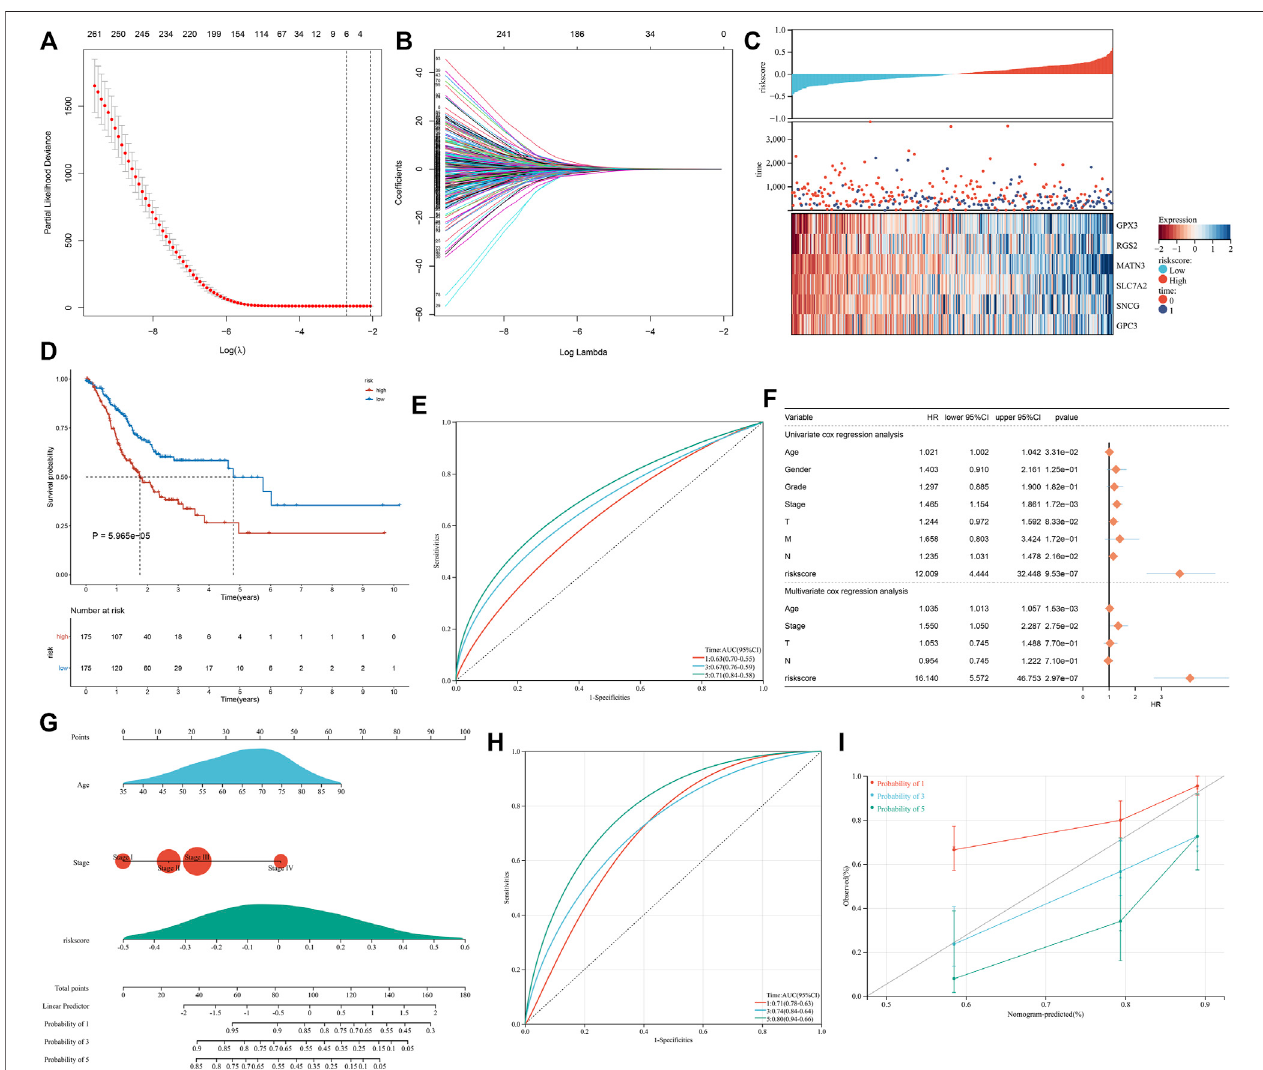
FIGURE 5 | Construction of the exosome-based gene signature for GC in TCGA cohort. (A) Partial likelihood deviance in the LASSO regression model via the ten- fold cross veri fi cation. The vertical dotted lines represent the optimal values utilizing the minimum and 1-SE criteria. (B) LASSO coef fi cient pro fi ling. (C) Overview of the risk score distribution (upper), survival status (middle), and expression of genes that made up the signature (lower). (D) Kaplan – Meier curves of OS in TCGA cohort, divided into high- and low-risk groups. (E) Time-independent ROC curves showing the prediction accuracy of this signature. (F) Forest plot showing the associations of risk score and clinical features with OS according to uni- and multivariate Cox regression models. (G) Construction of the nomogram that incorporated the risk score, age, and histological staging. (H) Time-independent ROC curves showing the prediction accuracy of the nomogram. (I) Calibration plot showing the agreement between the nomogram-predicted and actual 1-, 3-, and 5-year outcomes. The x-axis represents the nomogram-predicted OS, and the y-axis represents the actual OS. The ideal performance of the nomogram is shown by the dashed line along the 45 ° line.